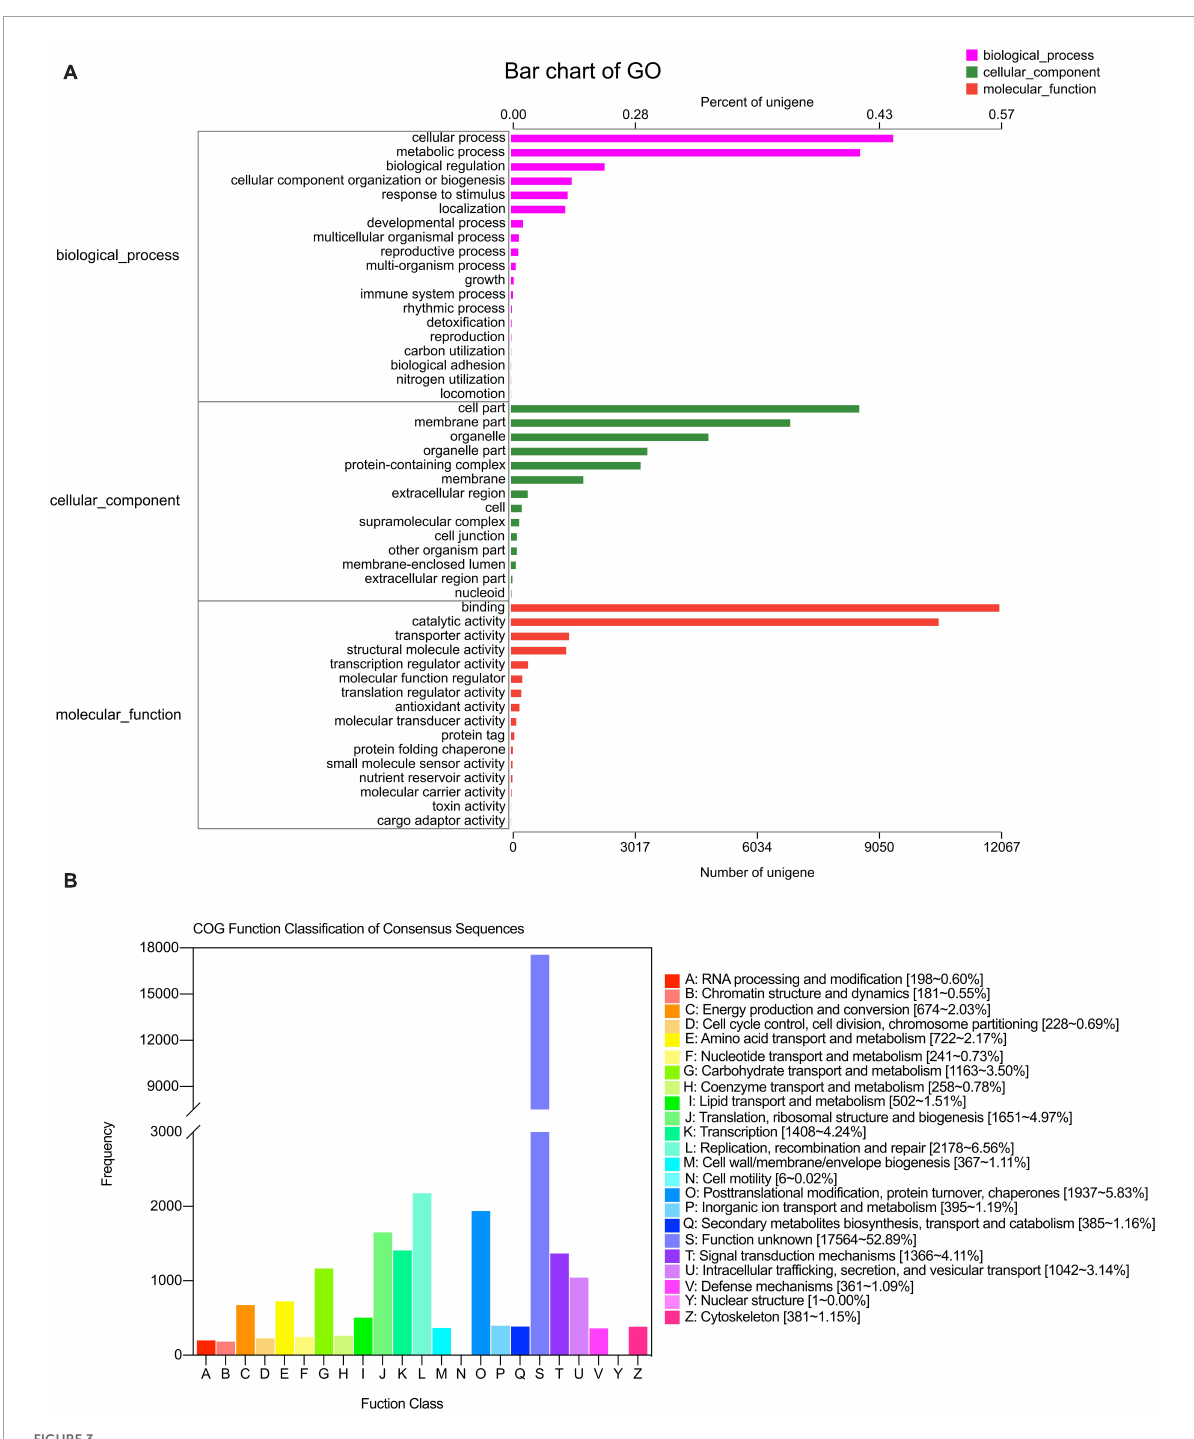
FIGURE3 GO (A) and COG (B) annotation of transcriptome in the leaves of S. portulacastrum under high salinity.